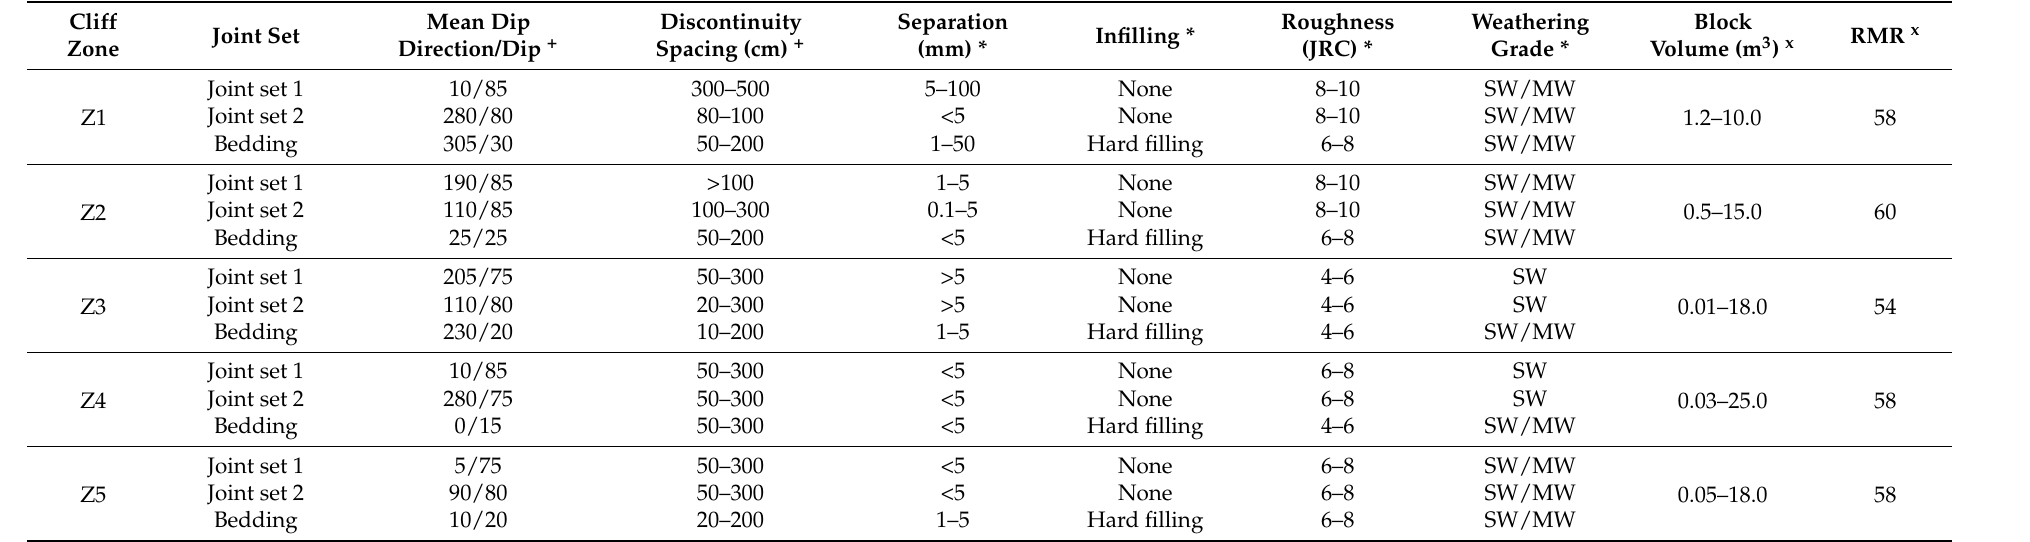
Table 4. The mean values of the joint set orientations and dip directions, discontinuity features, block volumes, and RMR values for each cliff zone based on results of in situ traditional geological and geotechnical surveys, remote sensing survey, and data analysis. Superscript * indicates data based on in situ traditional geological and geotechnical surveys, + indicates data based on remote sensing survey, while x indicates data obtained by data analysis. Abbreviations: JRC = Joint Roughness Coefficient; Weathering Grades: SW = Slightly Weathered, MW = Moderate